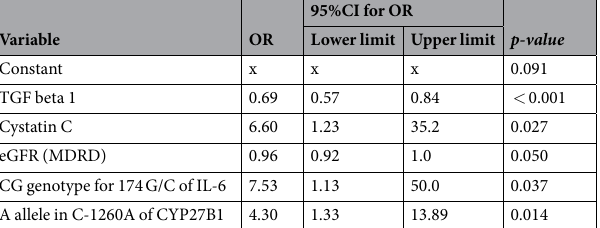
Table 5. Stepwise logistic regression assessing factors influencing limitations during activity in NYHA classification. Statistical analysis with stepwise logistic regression. ABBREVIATIONS: OR – odds ratio; CI – confidence interval; TGF beta 1 – t ransforming growth factor beta